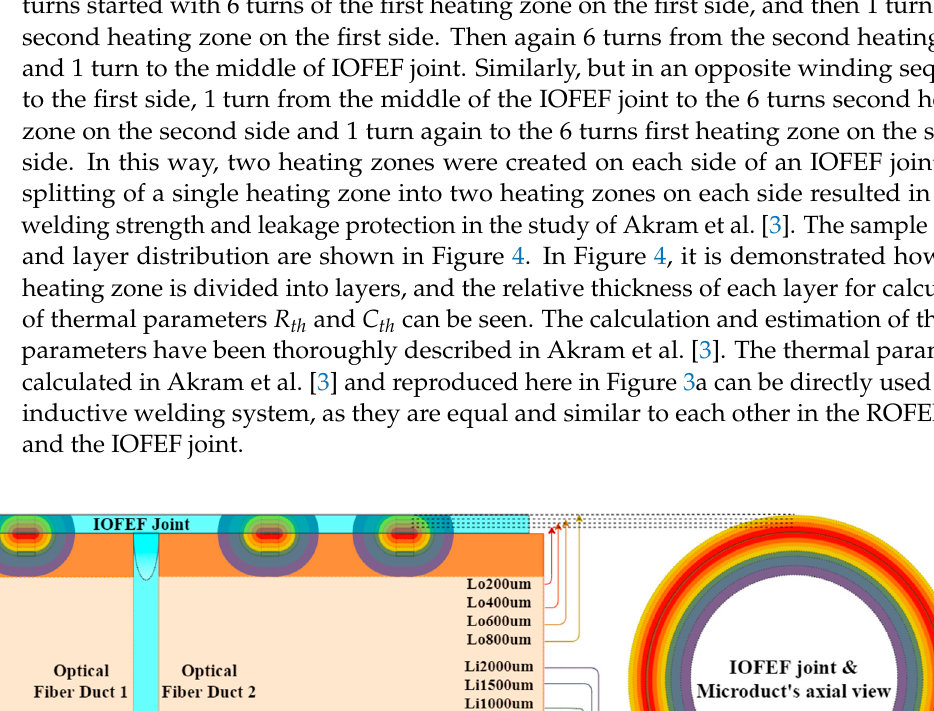
Figure 5. Work coil for power transfer to IOFEF joints.